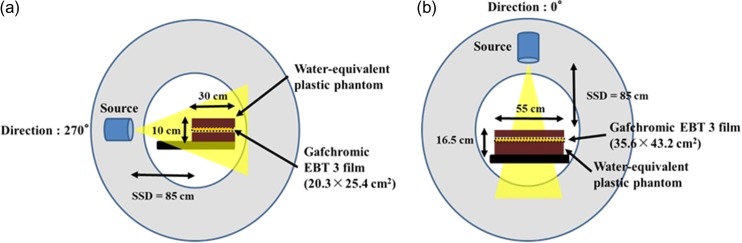
Geometry for the measurement of (a) PDD, (b) OCRx and OCRy. Gafchromic EBT3 films (20.3 × 25.4 cm2 for PDD, 35.6 × 43.2 cm2 for OCRx and OCRy), and rectangular water-equivalent phantoms were used for the measurements. The films were set at the center for PDD and at a 1.5-cm depth for OCRx and OCRy in the phantoms.